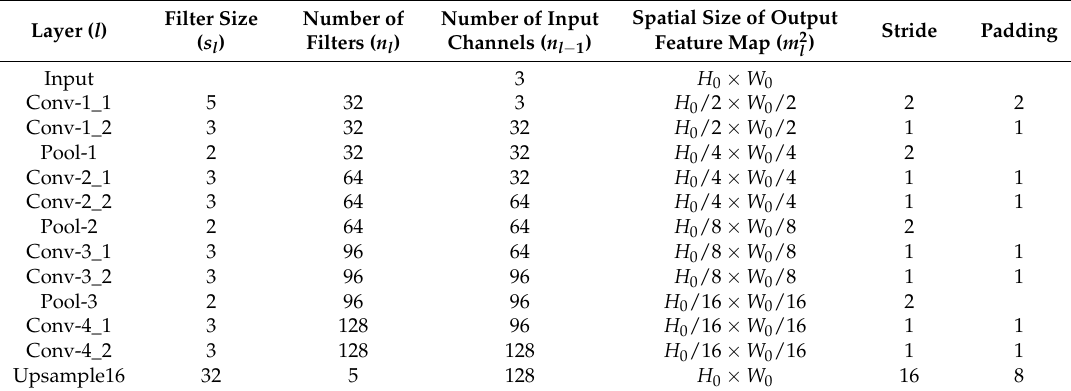
Table 4. Convolutional Layer Parameters of the Base FCN and FCN-8s.